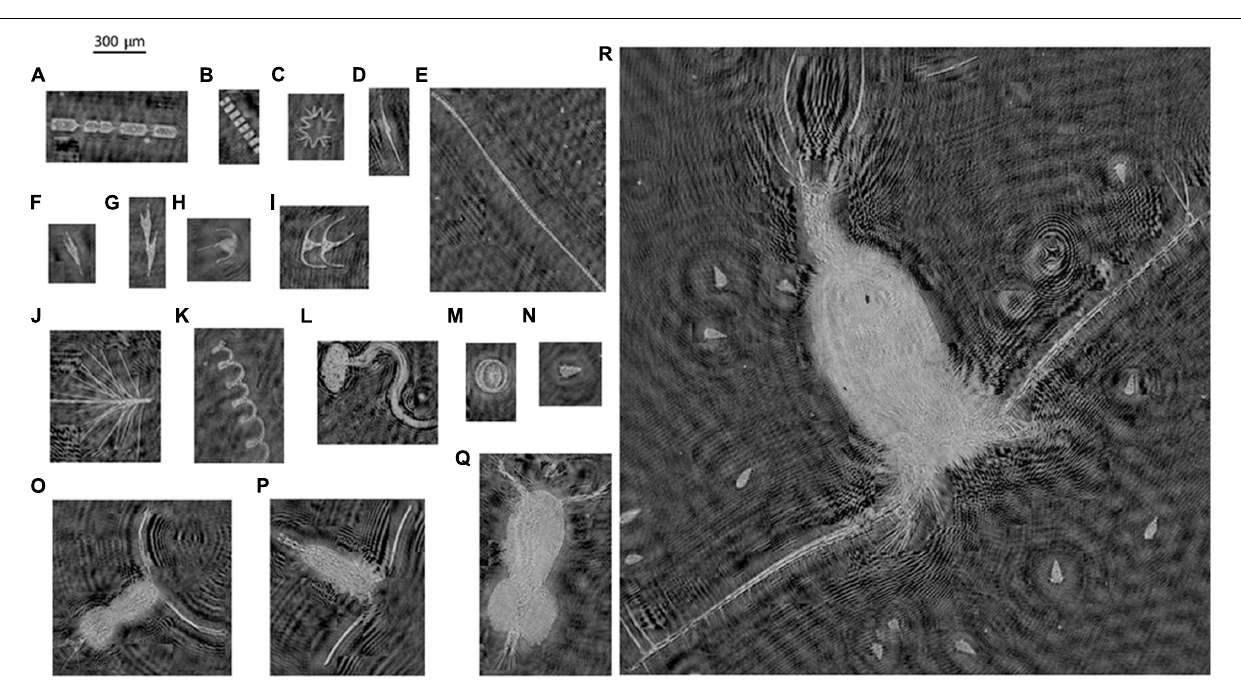
FIGURE 3 | A collage of different plankton recorded from diverse environments on field cruises in the Atlantic Ocean (Delaware shelf), the Gulf of Mexico and East Sound, Washington, a coastal fjord in the Pacific Northwest. (A) Ditylum brightwelli ; (B) Thalassiosira sp.; (C) Thalassionema sp.; (D) Tripos cf. fusus ; (E) Unidentified colony; (F) Tripos cf. furca ; (G) Tripos cf. furca , dividing cell; (H) Tripos muelleri ; (I) Tripos sp. dividing; (J) Chaetoceros sp.; (K) Chaetoceros cf. debilis ; (L) Appendicularian; (M) Coscinodiscus sp.; (N) cf. Strombidium sp.; (O) Calanoid copepod with egg sac; (P) Calanoid copepod; (Q) Cyclopoid copepod with paired egg sacs; and (R) Unidentified large copepod, potentially feeding on cf. Strombidium